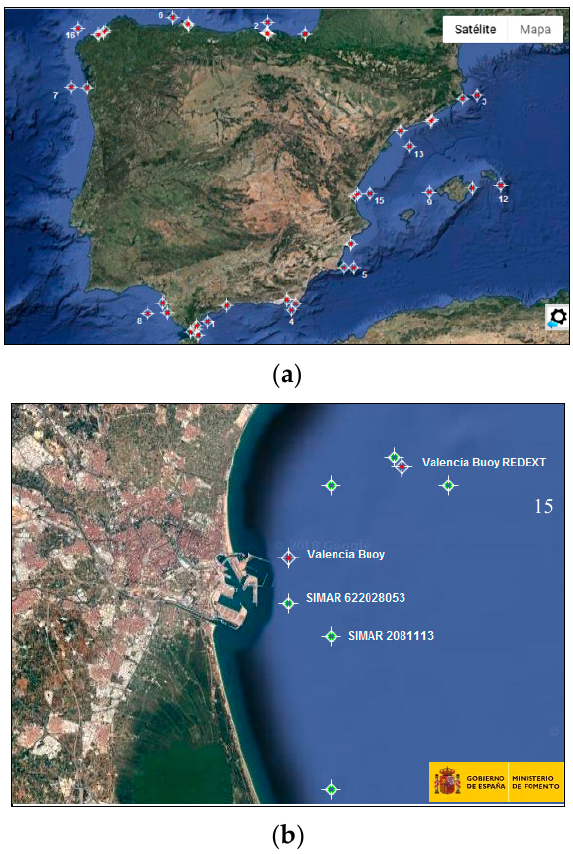
Figure 10. ( a ) REDEXT buoys according to Table 6. ( b ) Location of Valencia Buoy, SIMAR 2081113 and SIMAR 622028053 points. Source: www.puertos.es.